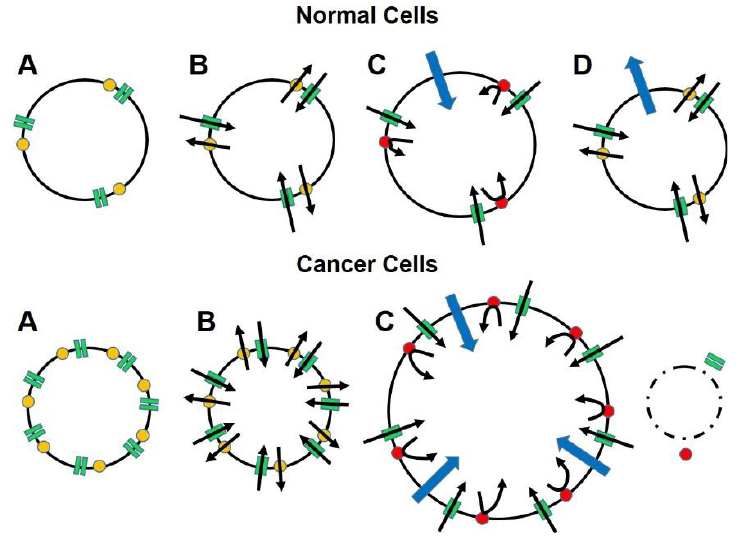
Figure 1. The diagram illustrates how advanced cancers that greatly over-express the conserved and ubiquitous sodium channel/sodium pump mechanism that is essential for cell function and survival, carry their own means of destruction and that by manipulating this mechanism, cancer cells can be eliminated without affecting normal cells. Panels A show that relative to normal cells, cancer cells greatly over express voltage-gated sodium channels (VGSCs; green rectangles) and Na + , K + -ATPase (yellow dots) more than even highly-expressing normal cells (e.g., nerve and muscle). Panels B show that the functional ratio of VGSCs to sodium pumps is maintained in cancer cells to ensure that the influx of sodium ions (inward oriented black arrows) that occurs down a concentration gradient when the membrane is depolarized and the channels are open can be rapidly reversed (outward oriented black arrows), thereby restoring normal resting membrane potential and intracellular sodium ion concentrations. Panels C show that when the sodium pumps are blocked (red dots) sodium ions enter the cells in direct relation to the number of VGSCs but cannot be returned to the extracellular space. Water enters the cells osmotically (blue arrows) to dilute the intracellular sodium concentrations, causing cell swelling. Panels D show that the amount of water that enters the cancer cells exceeds the cell membrane’s capacity to comply, resulting in cell lysis. In normal cells, the sodium pumps return to normal functioning when the blocking agent clears. The smaller amount of water follows the sodium ions back to the extracellular space, returning the cells to normal configuration and functioning.